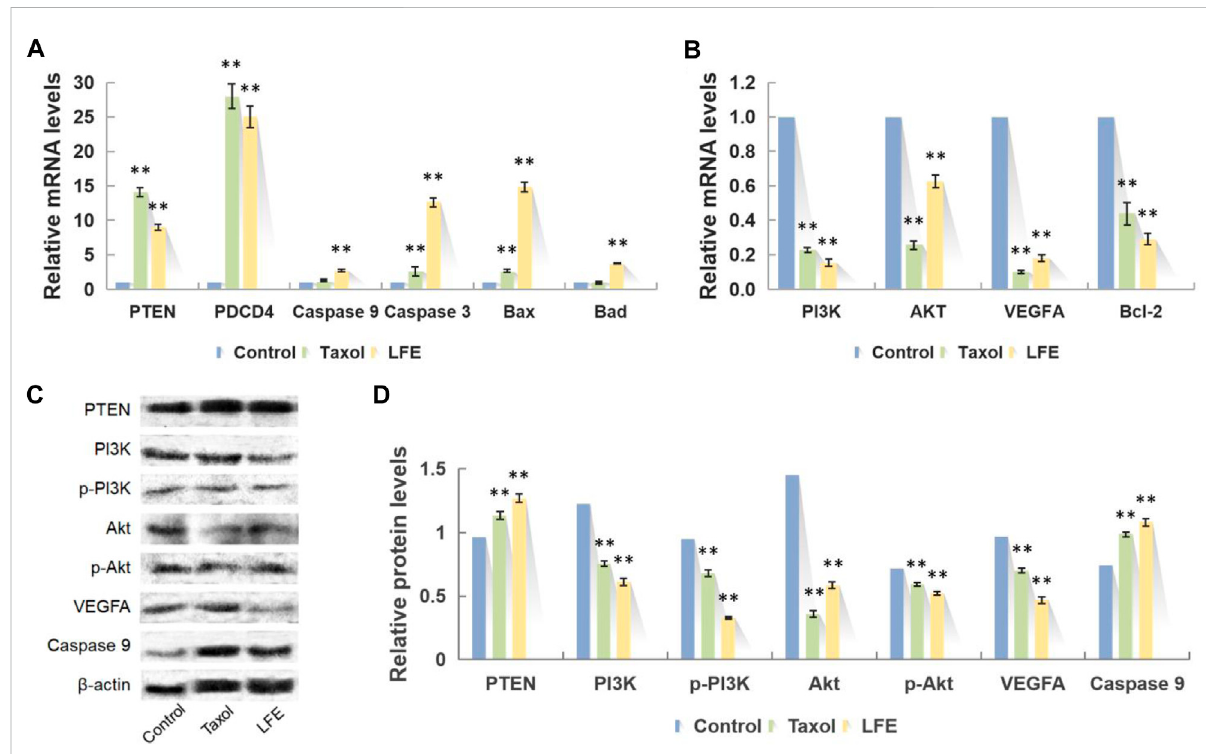
FIGURE 7 Representative photographs of q-PCR and Western blot. (A) Upregulated mRNA after LFE treatment. (B) Downregulated mRNA after LFE treatment. (C) Representative western blots showing PTEN, PI3K, p-PI3K, Akt, p-Akt, VEGFA and Caspase 9 after LFE treatment. (D) Relative protein levels after LFE